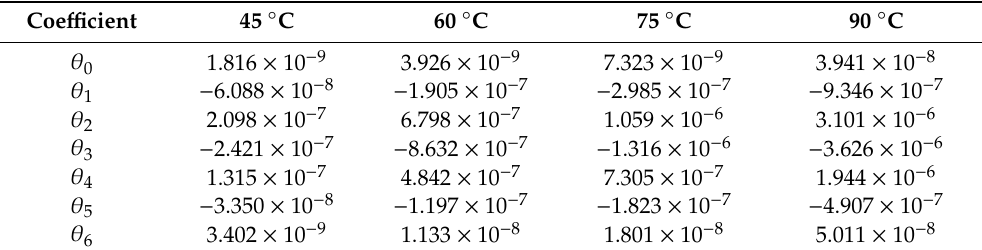
Table 3. Coe ffi cient θ j of cellulose pressboard with moisture content of 1.13% Table 3. Coefficient θ j of cellulose pressboard with moisture content of 1.13%